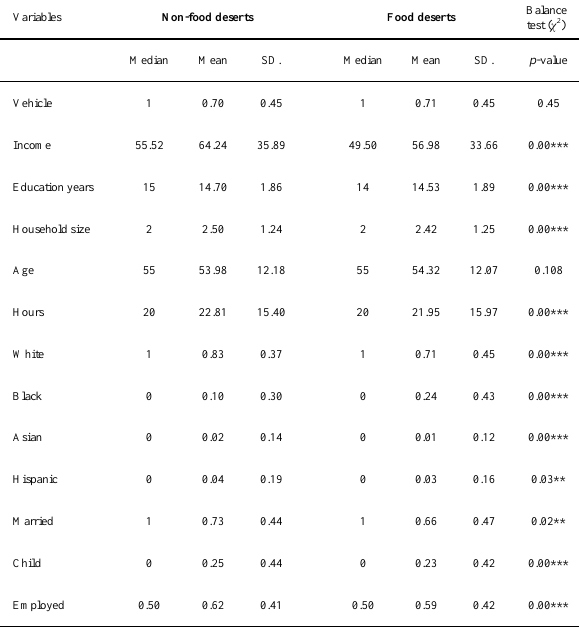
Table 1. Descriptive statistics of household characteristics by food desert